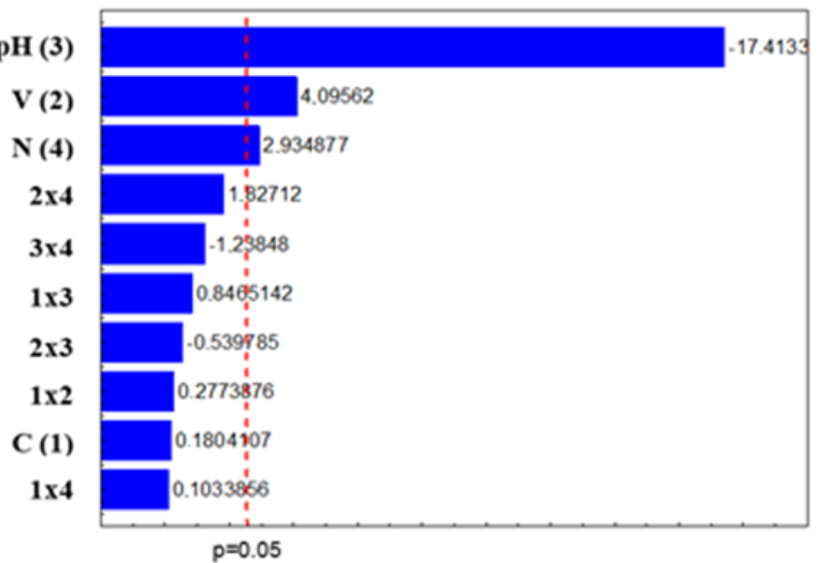
Figure 1. Pareto graph of standardized effects at p = 0.05 for disulfoton degradation. It can be seen that pH had the greatest influence on the degradation rate. In [14], it was found that the reaction is favorable in an acid medium with a pH between 3 and 5 for degradation by the Fenton process. According to Pignatello [15], the pH of the medium plays a fundamental role in the efficiency of the Fenton and photo-Fenton processes. The values above 3.0 cause Fe (III) to precipitate in the form of insoluble hydroxide, and at values below 2.5, high concentrations of H + can sequester hydroxyl radicals. There is also a predominance of less hydroxylated species that have less absorptivity, with the need for pH control being the biggest limitation of these processes. However, no significant differences were observed in the samples due to the change in